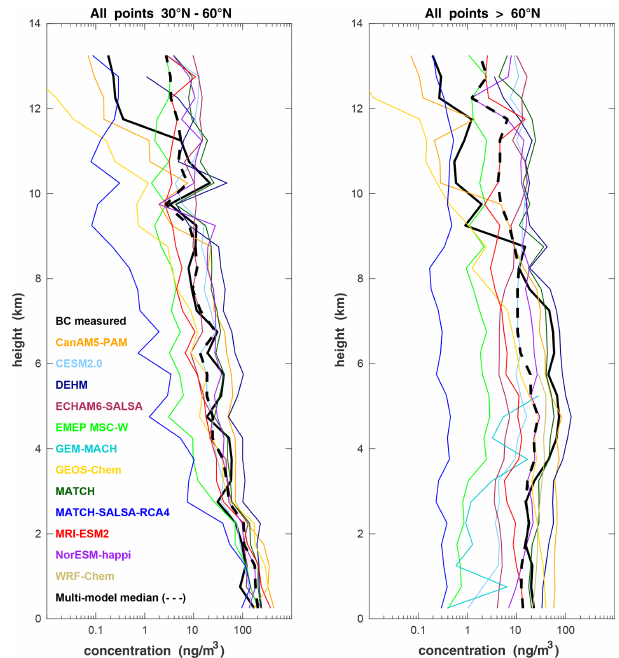
Figure 16. Median vertical profiles of observed (heavy black line) and modeled (colored lines) BC concentrations for all aircraft cam- paigns combined, separated into (left) midlatitudes and (right) the Arctic. The multi-model median is shown by the dashed black